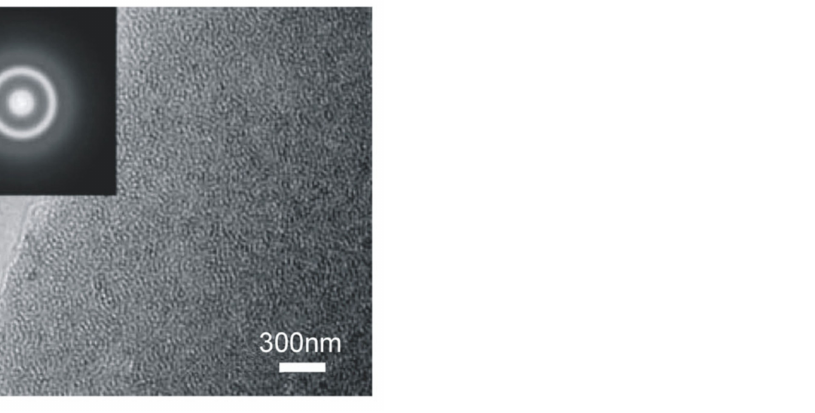
Figure 7. High-resolution transmission electron microscope image with the corresponding selected area diffraction pattern (inset) for La − Si − O − N glass [9].